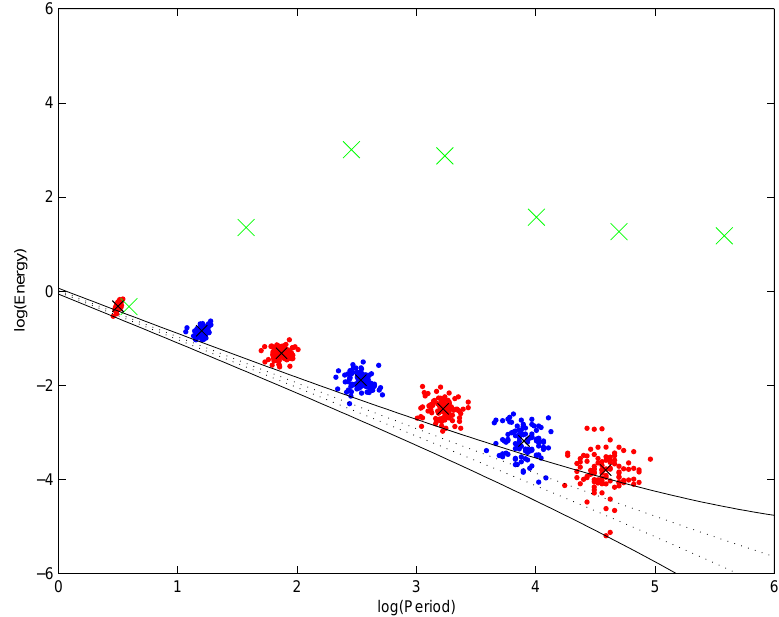
Fig. 4. Log-log diagram of the energy and dominant period of the different intrinsic modes identified by the EMD technique. The separation between observations (green crosses) and Monte-Carlo simulations of red-noise (red and blue dots) displayed in this figure indicate that a range of atmospheric waves can be observed in the Scott Base MF radar data. The black crosses in this figure indicate the center of mass for the individual IMFs produced by the Monte-Carlo simulations. The dotted and full lines indicate the theoretical bounds (75% and 99% limits) within which white-noise should fall.